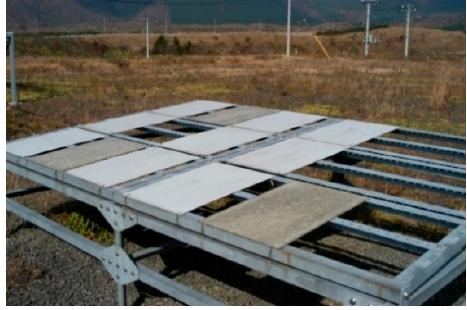
Figure 3. Specimens placed on exposure racks facing south on a 5° slope.